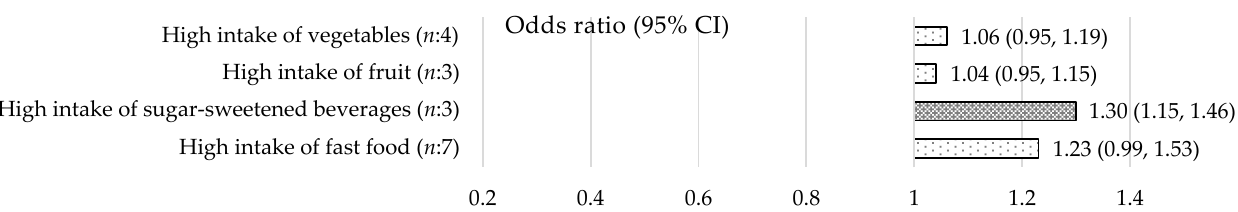
Figure 4. Association between a high intake of four different food and beverages categories and risk of overweight/obesity in adolescents 12–18 years. OR < 1 = decreased risk of overweight/obesity, OR > 1 = increased risk of overweight/obesity. Dark shades are significant ( p ≤ 0.05). White shades are not significant. The forest-plots for each food or beverages category is available in Supplementary Figures S25–S28 .